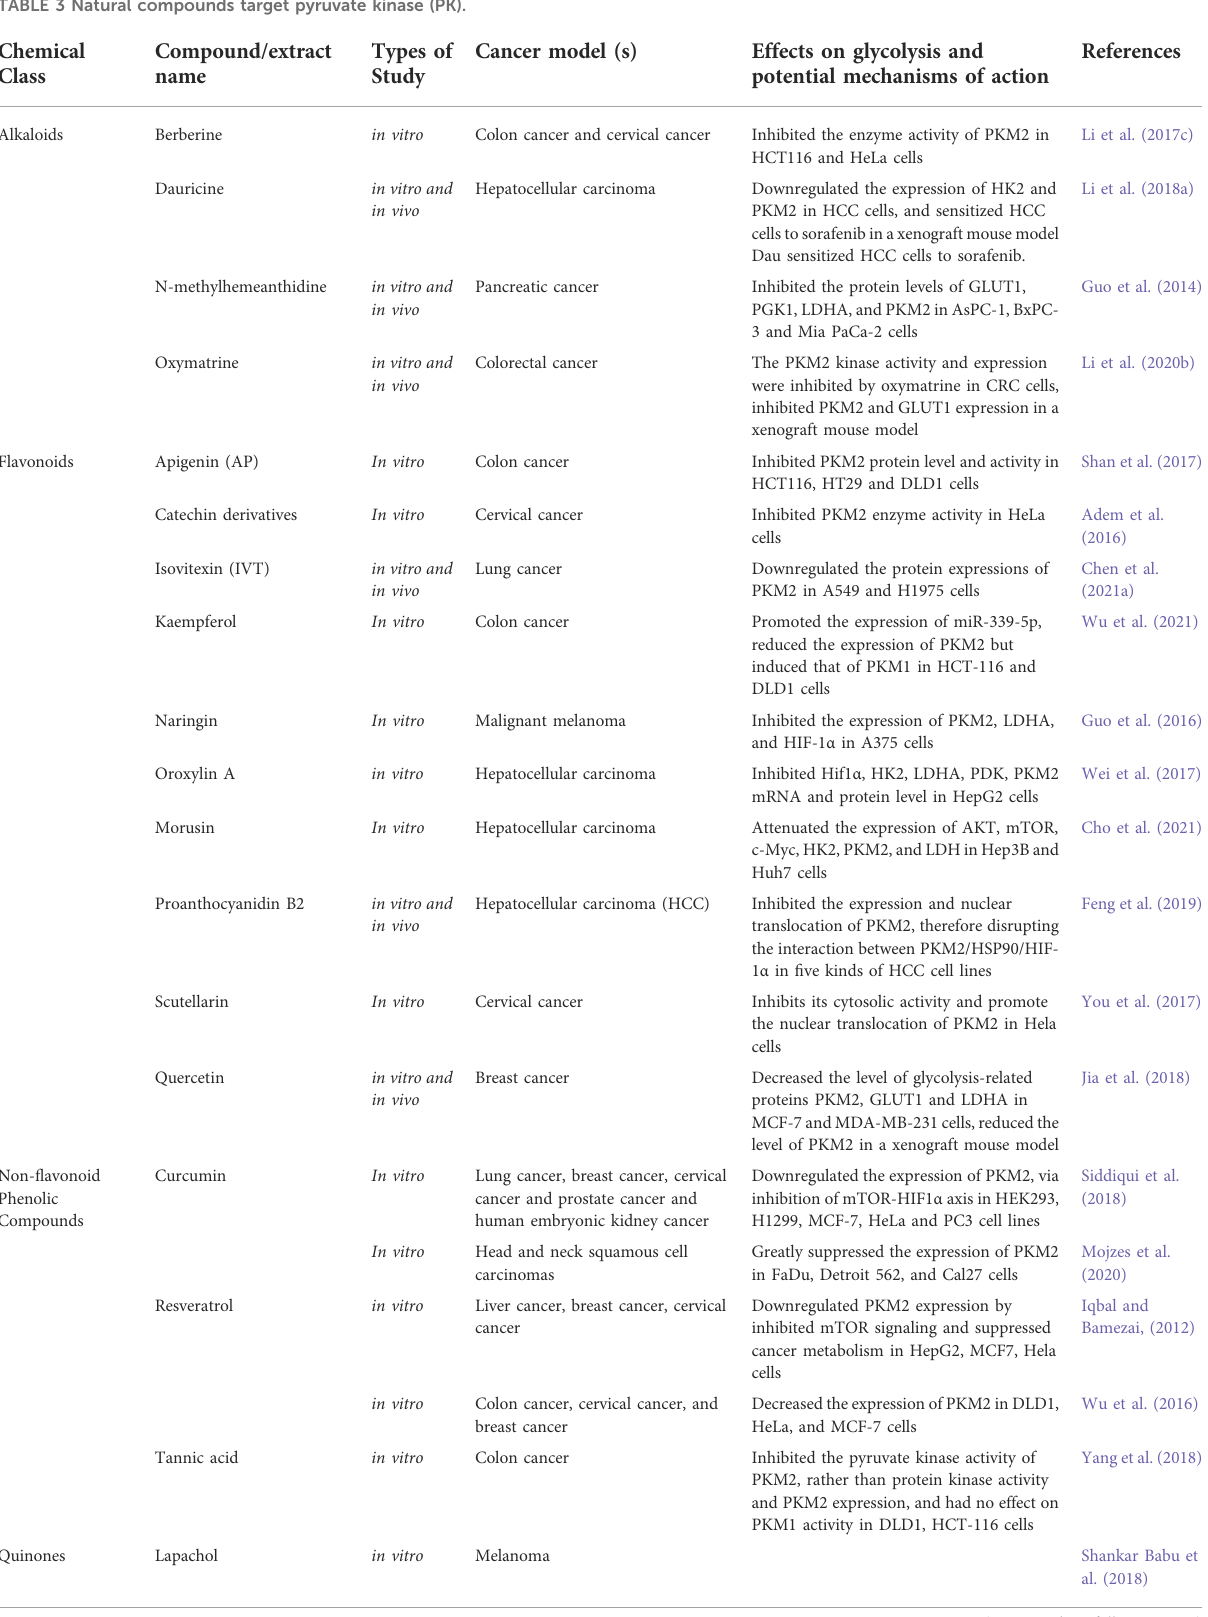
TABLE 3 Natural compounds target pyruvate kinase